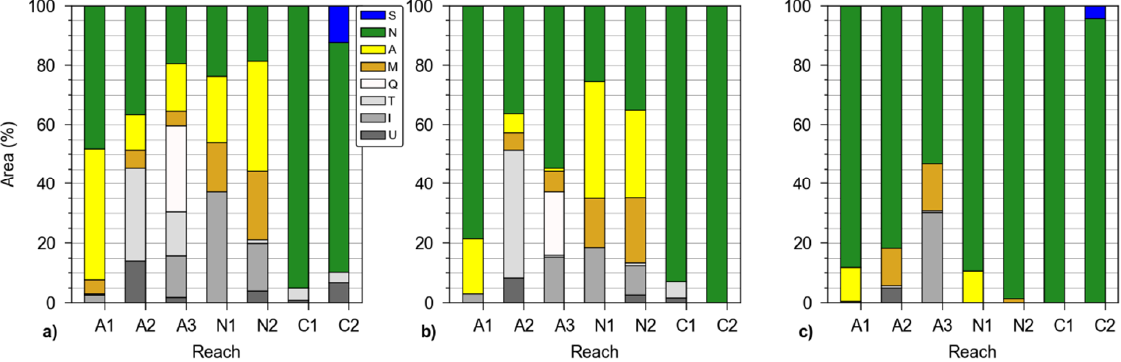
Figure 10. Current LULC in the abandoned areas of the ( a ) 1930, ( b ) 1954 and ( c ) 1973 active-channels. S: sea; N: natural and seminatural area; A: agricultural area; M: abandoned man-made area; Q: quarry area; T: transport area; I: industrial area; U: urban area.